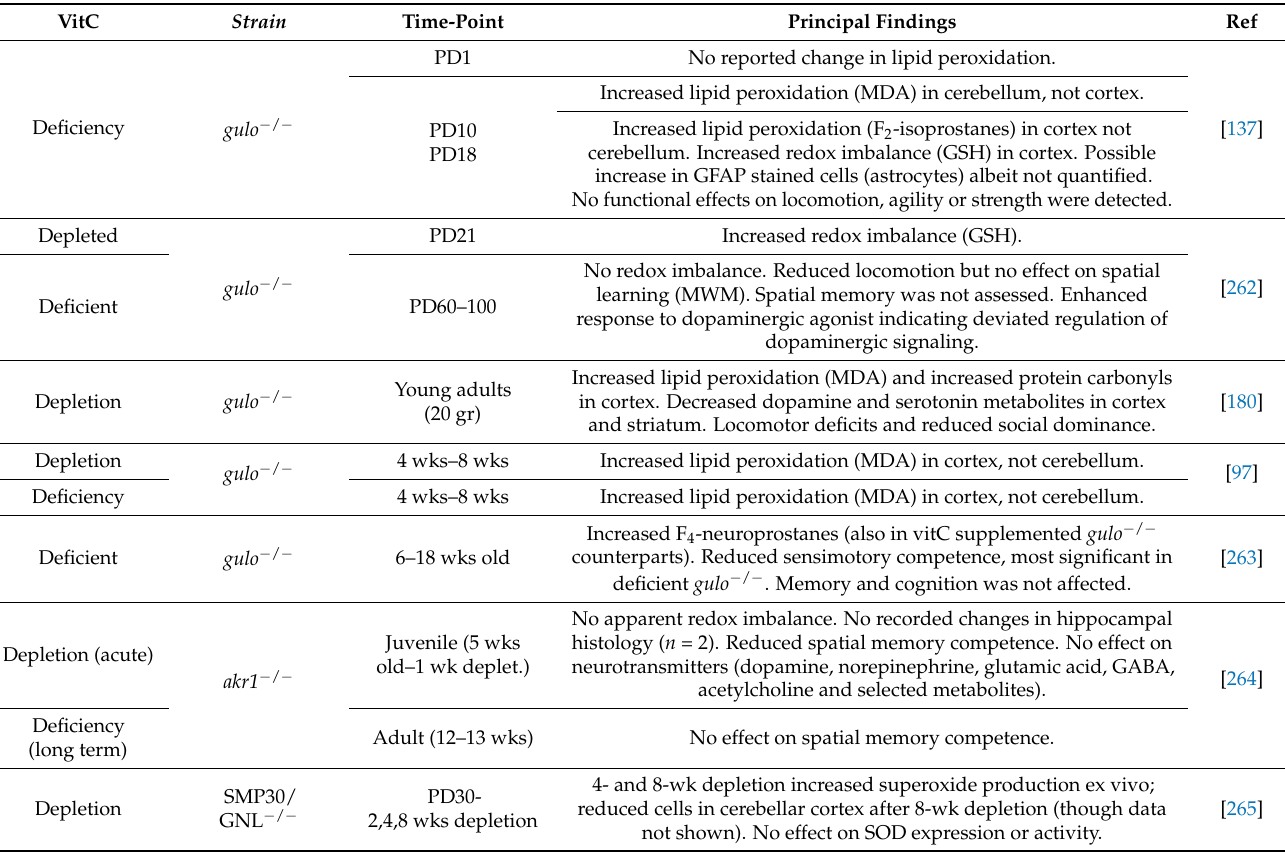
Table 2. Principal findings of postnatal vitamin C deficiency in the brain—findings from murine